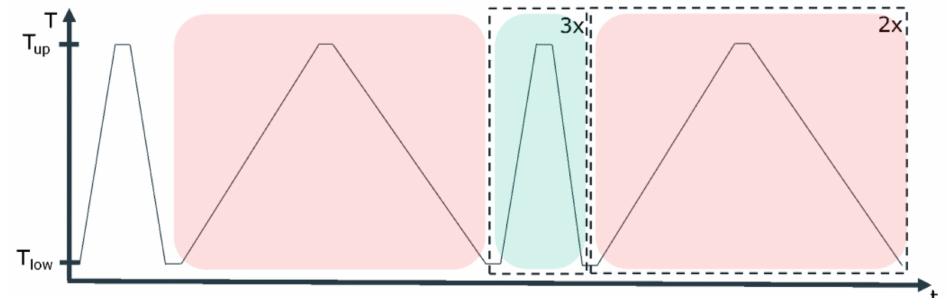
Figure 1. Complete temperature program for the di ff erential scanning calorimetry (DSC) measurements. The upper and lower temperature limits, T up and T low , are indicated, as well as the two heating rates applied in the experiment. The dashed boxes indicate the number of repetitions per heating rate, while the colored boxes indicate the segments used for